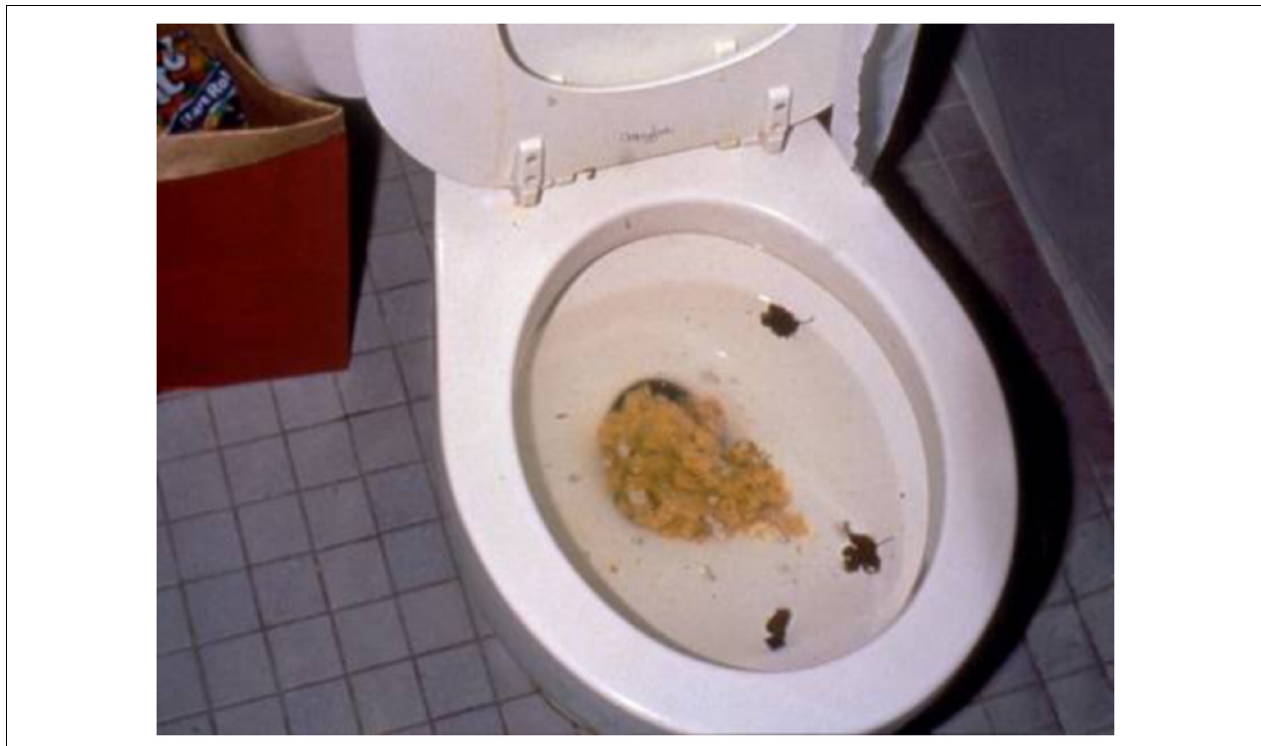
FIGURE 2 | An example of stimuli used in the experiment: